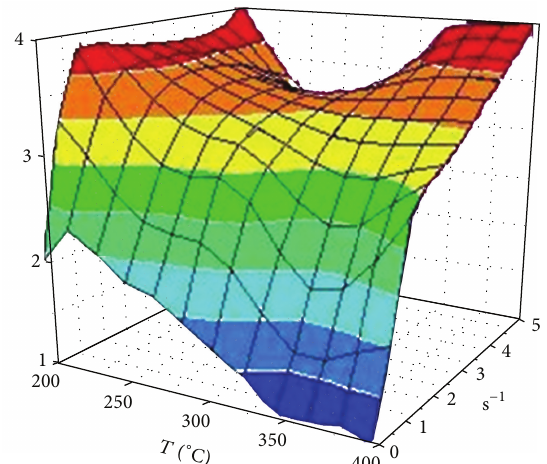
Figure 1: Relationship among macroscopic morphology, deforma- tion temperature, and strain